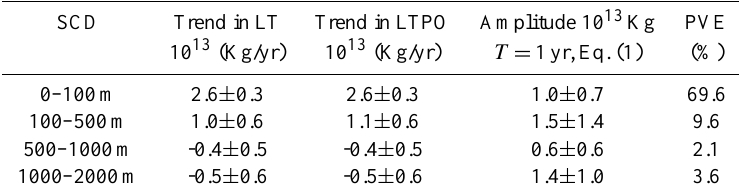
Table 4. SCD for the whole basin at different layers; the uncertainty is at the 95% confidence level.